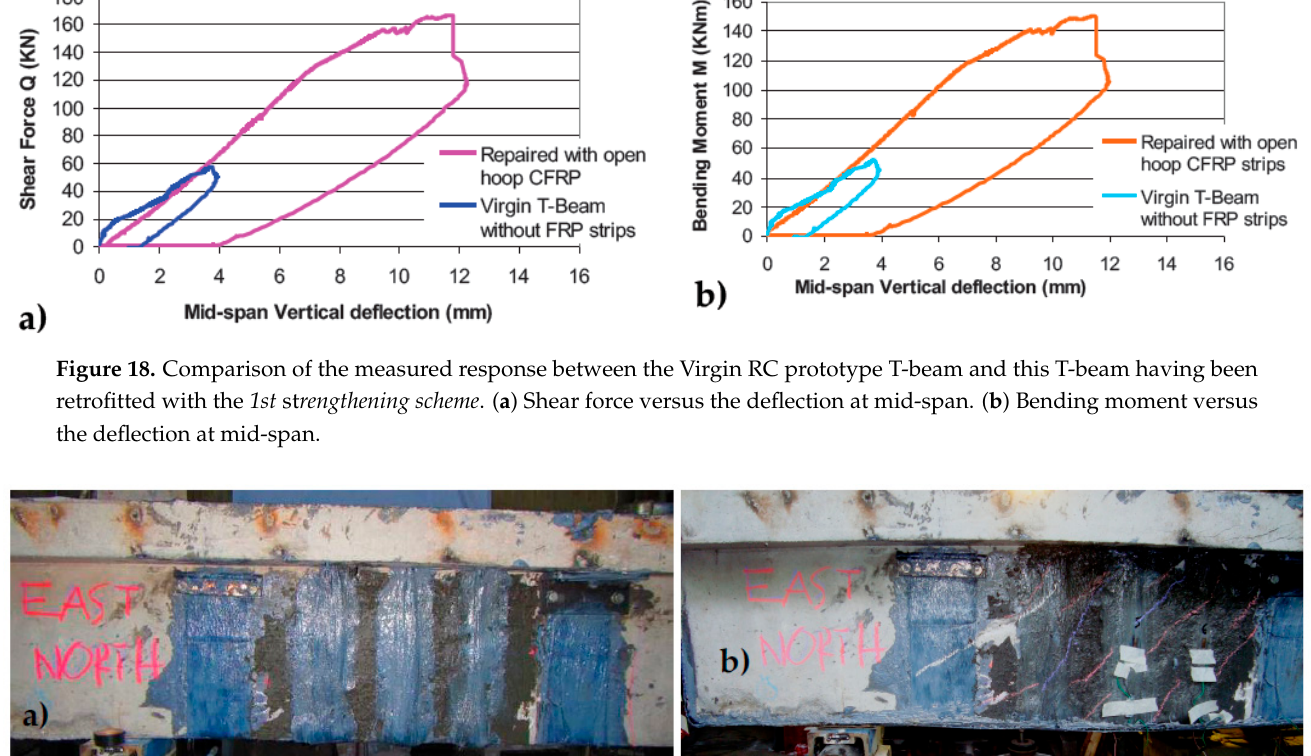
Figure 19. ( a ) The 2nd st rengthening scheme (East part). ( b ) Diagonal shear cracks at the East part of the prototype RC T-beam, which were checked by the applied CFRP anchor poles.